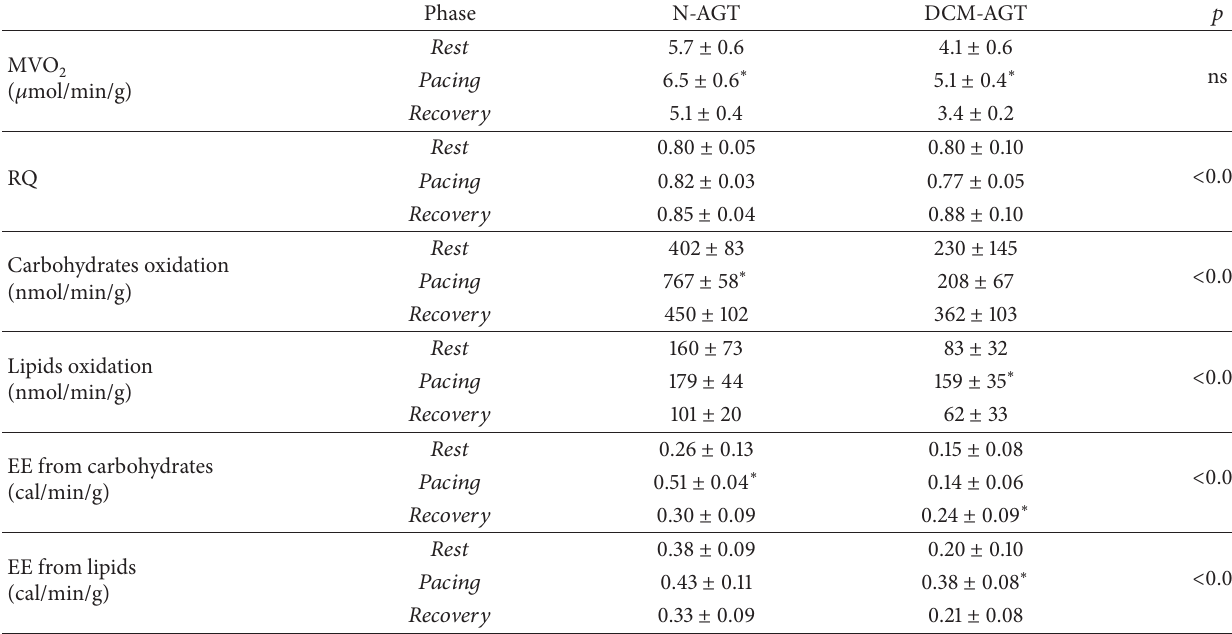
Table 3: Gas analysis data.